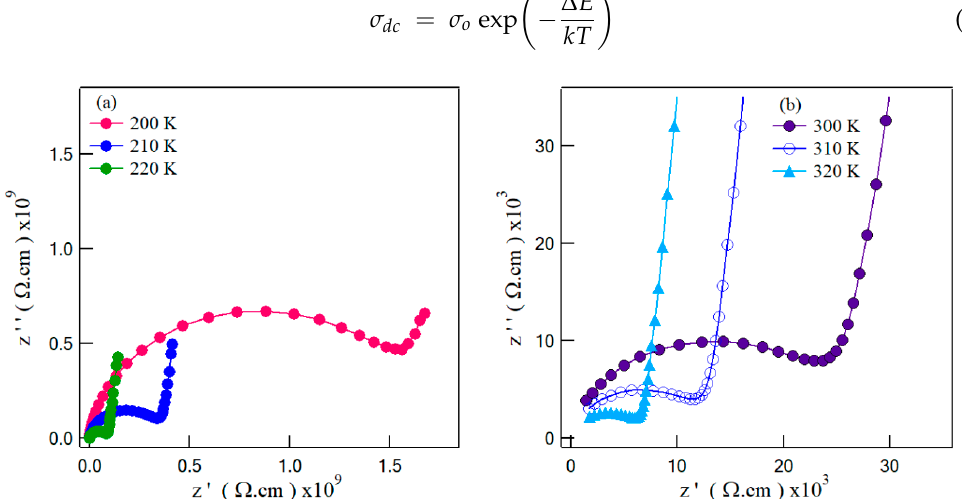
Figure 3. Complex impedance diagrams at selected temperatures for Li 5.6 La 3 Ta 1.7 Ga 0.3 O 12 garnets at ( a ) low and ( b ) high temperature regions.